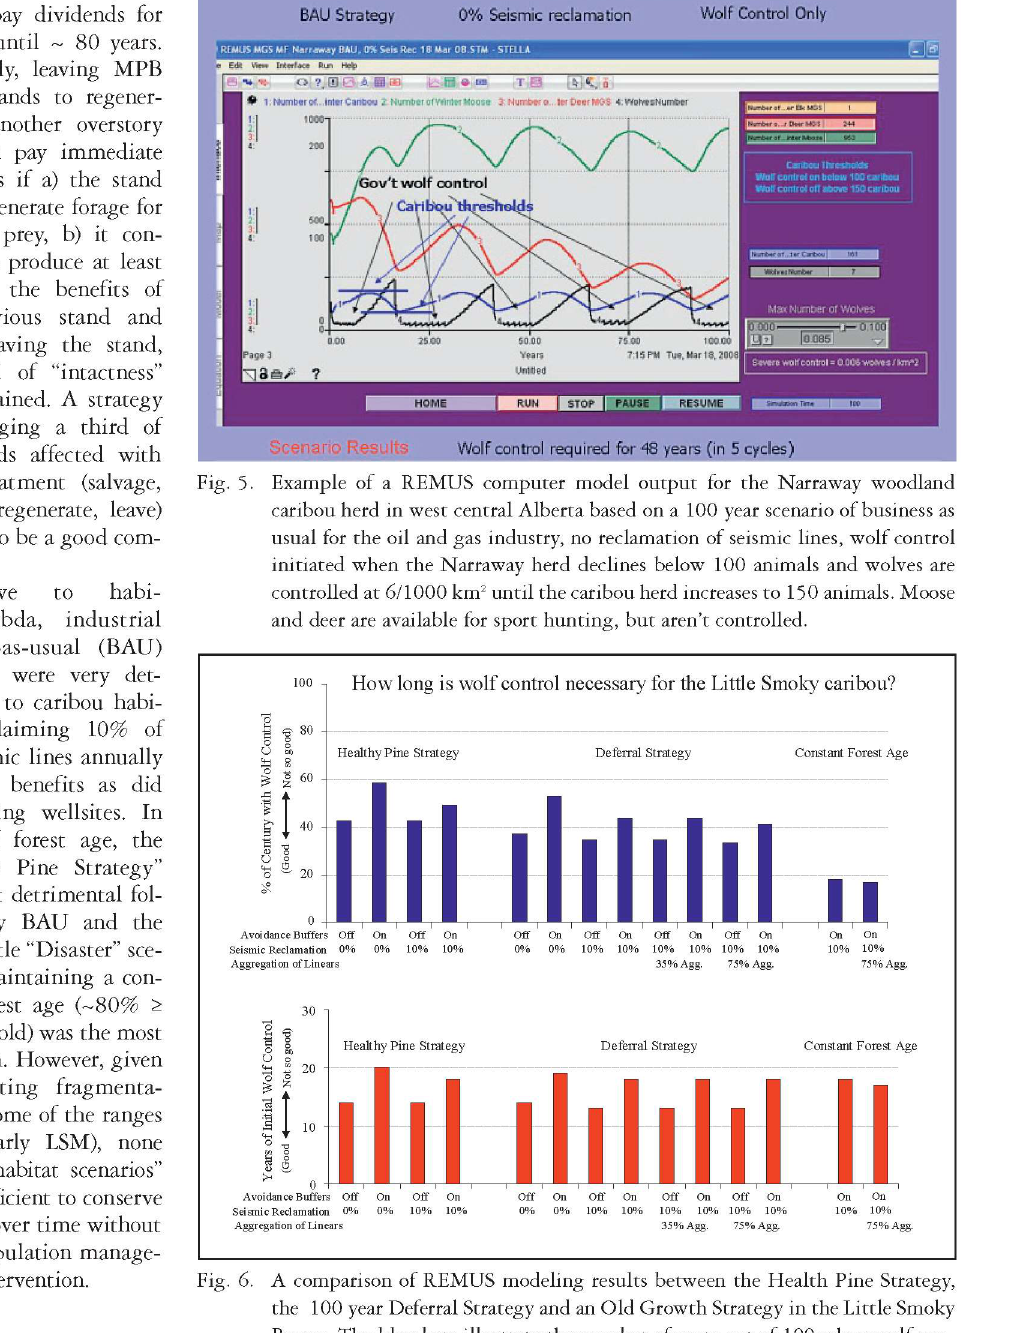
Fig. 6. A comparison of REMUS modeling results between the Health Pine Strategy, the 100 year Deferral Strategy and an Old Growth Strategy in the Little Smoky Range. The blue bars illustrate the number of years out of 100 when wolf con¬ trol would be necessary and the red bars illustrate how many years would be initially required to achieve 150